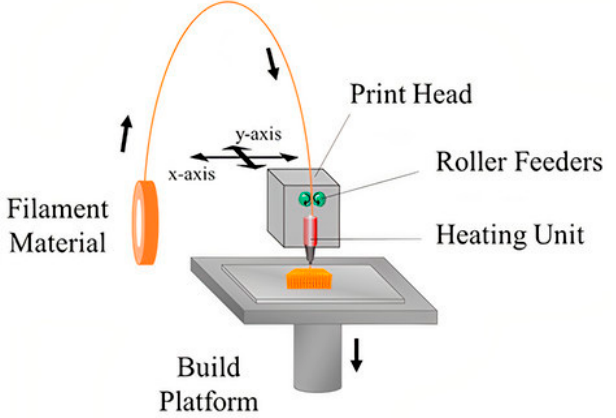
Figure 4. Fused Deposition Modeling. Reprinted with permission from Tamay, D., et al. 3D and 4D Printing of Polymers for Tissue Engineering Applications. Frontiers in Bioengineering and Biotechnology 7. Copyright (2019) Frontiers [110].